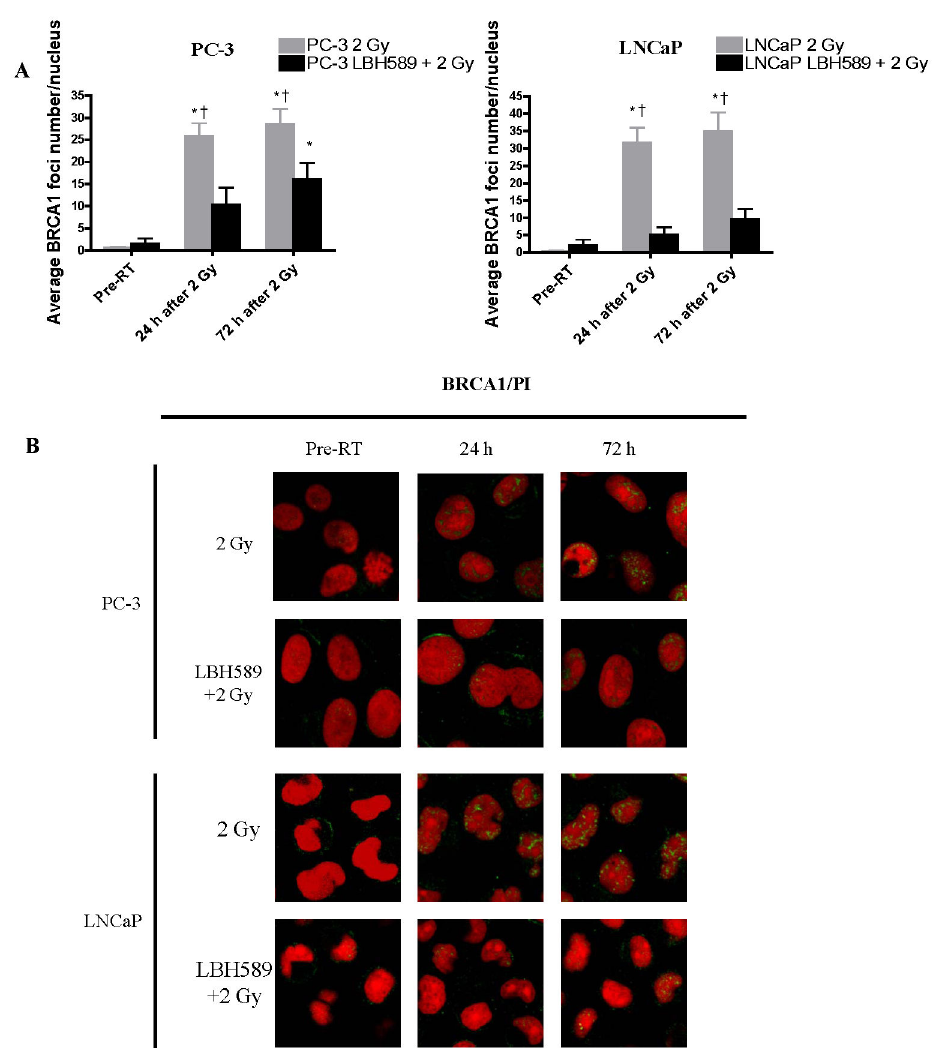
Figure 5. Quantitative analysis of DSB repair marker in the HR pathway for BRCA1 foci at pre-RT, 24 h and 72 h after 2 Gy RT or combination treatment in PC-3 and LNCaP cells. ( A ) After 2 Gy RT, average BRCA1 foci number increased significantly at 24 h in both PC-3 and LNCaP cells and maintained increased at 72 h, while average BRCA1 foci number in combination-treated (LBH589+2 Gy RT) cells was also increased at 24 and 72 h, but was significantly lower than that in RT-treated cells. ( B ) Representative images of BRCA1 staining after 2 Gy RT or combination treatment (LBH589+2 Gy RT) in PC-3 and LNCaP cells. p <0.05(†) indicates significant difference between RT-treated cells and combination-treated cells at the same time point. p <0.05(*) indicates significant difference between cells at specific time points and cells receiving the same treatment at the “Pre-RT” time point. Points, mean; bars, SD. N=50. Typical images are shown from three independent experiments (N=3). Magnification × 60 in all